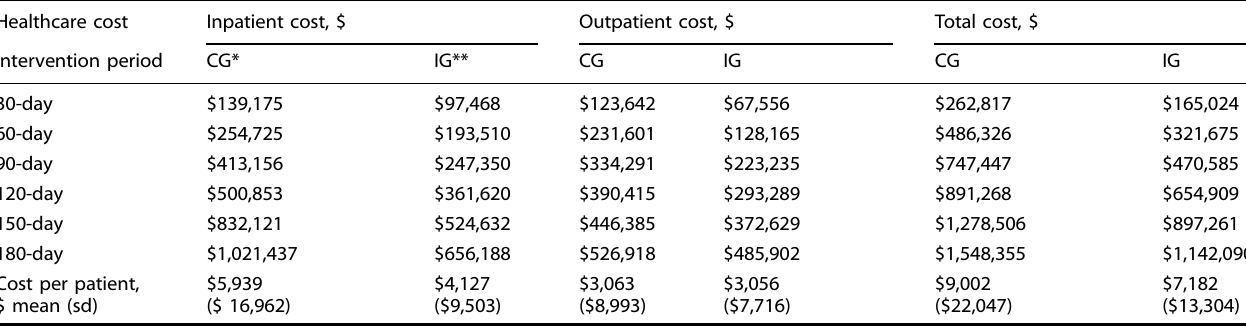
Table 3. Summary of healthcare costs in both groups during the intervention